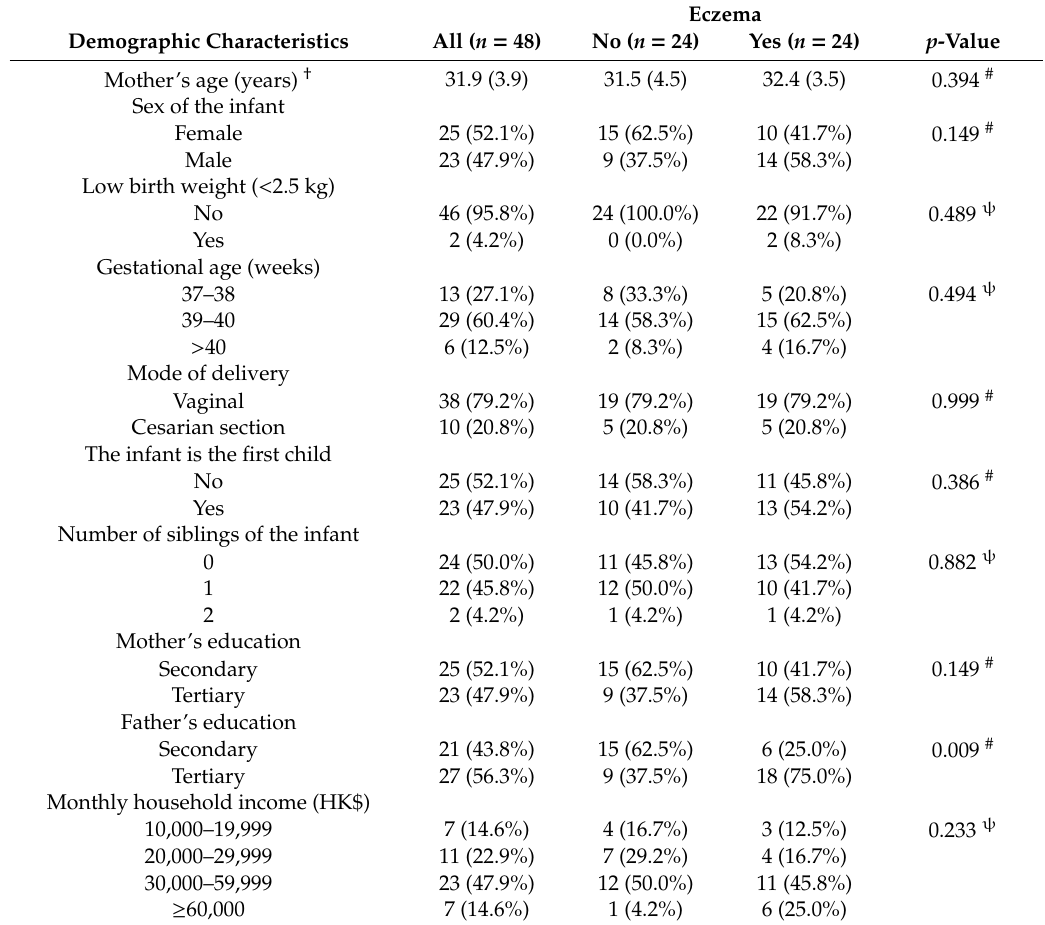
Table 1. Demographic characteristics of the participants ( n = 48).